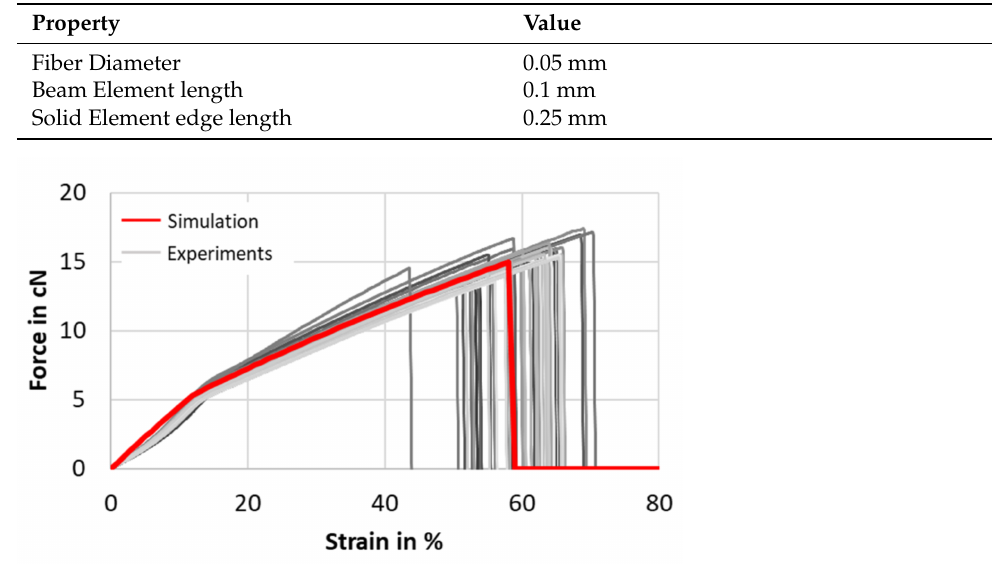
Figure 7. Tensile curve of Polyamide 6 fibers.